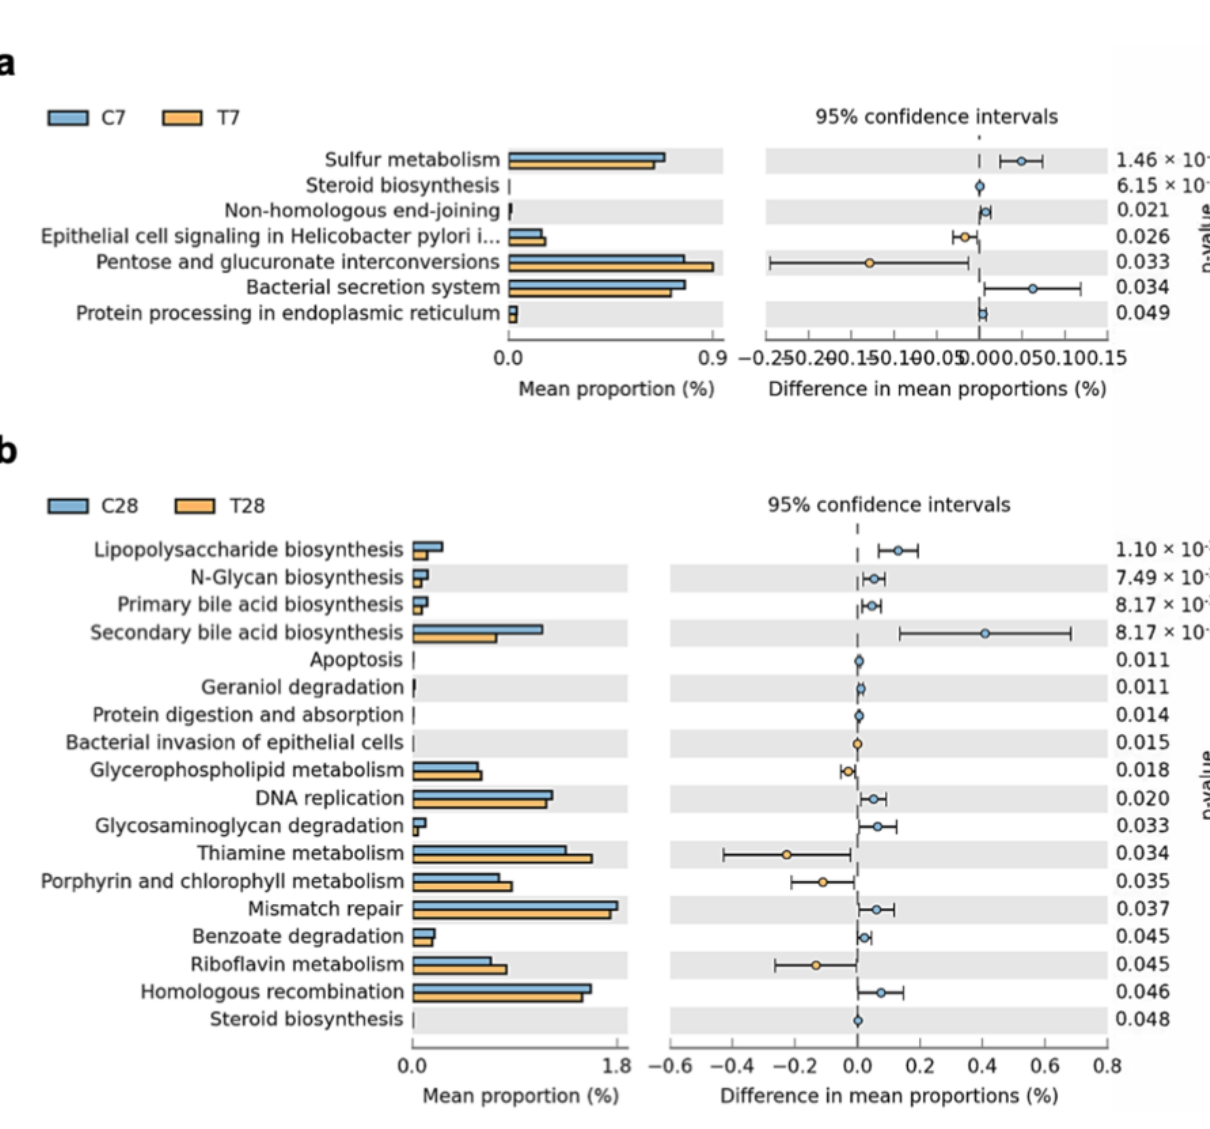
Figure 10. Functional difference analysis of gut microbiota. A comparison of the KEGG functional categories inferred from the 16S rRNA gene sequences using PICRUSt at 7 days ( a ) and 28 days ( b ) post-TBI. ( n = 6 per group). KEGG, Kyoto Encyclopedia of Genes and Genomes; PICRUSt, phylogenetic investigation of communities by reconstruction of unobserved states.